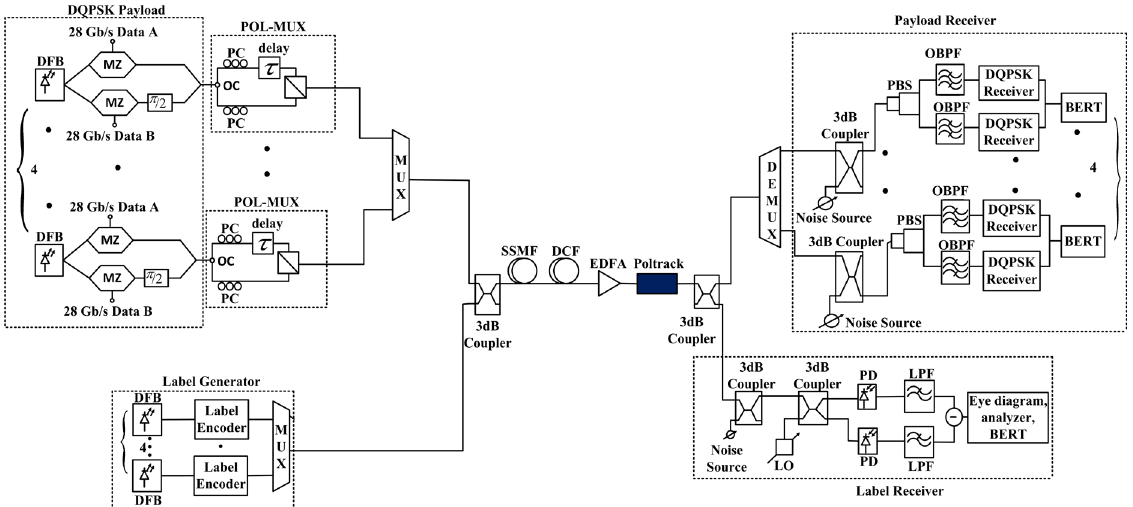
Fig. 3 Simulation setup of 112 Gb/s × 4 WDM 100 Gb/s channel spacing PDM-DQPSK SAC label